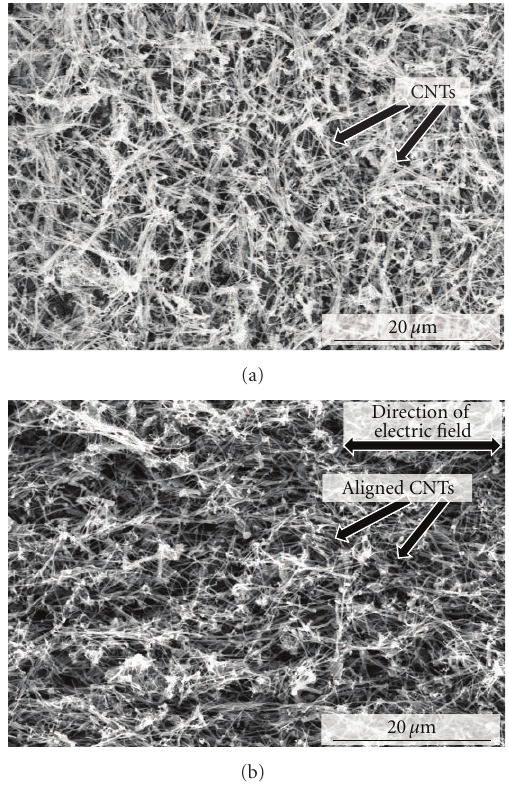
Figure 7: SEM image of CNT-composite-paper with CNT density of 0.1136 mg/cm 2 ((a) nonalignment control and (b)